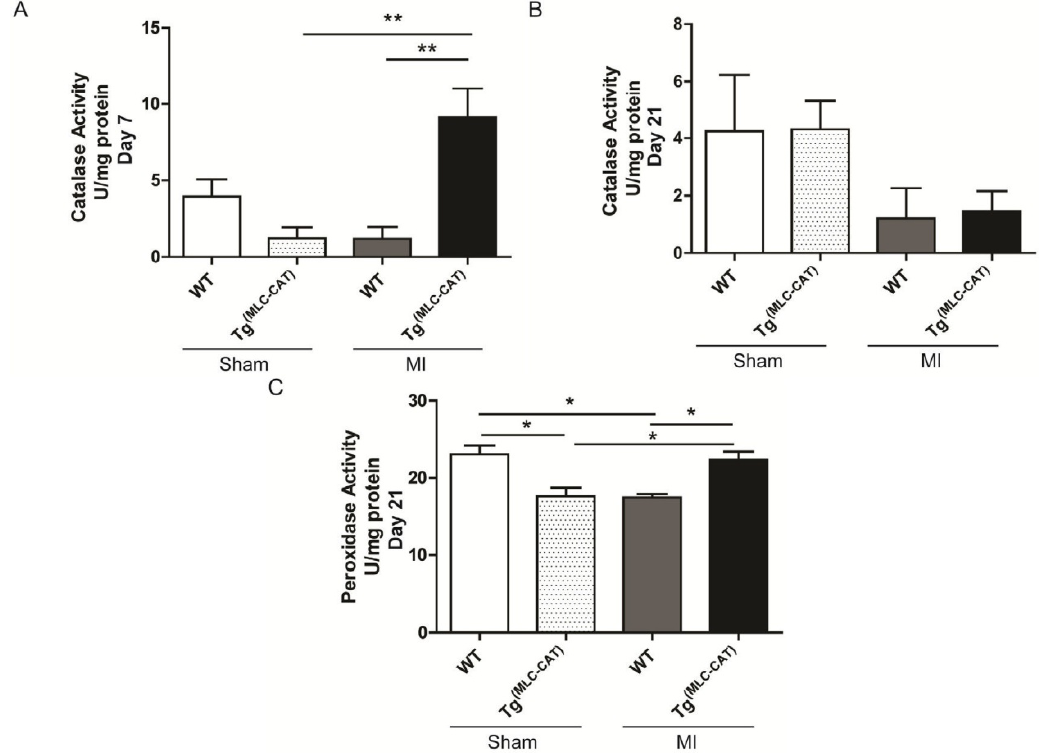
Figure 2. Catalase activity acutely increased in Tg (MLC − CAT) mice as compared to WT mice. ( A ) Catalase activity was significantly increased at 7 days following myocardial infarction in Tg (MLC − CAT) mice as compared to WT mice. This increase in activity was also significant as compared to sham operated animals. Values are mean ± SEM; n = 5 per group; ** p < 0.01 ANOVA followed by Bonferroni post-test; ( B ) At 21 days, catalase activity in Tg (MLC − CAT) mice showed no significant difference from WT mice activity levels. Values are mean ± SEM; n = 5–7 per group; ( C ) Non-catalase peroxidase activity was significantly increased in Tg (MLC − CAT) mice as compared to WT mice at 21 days. Values